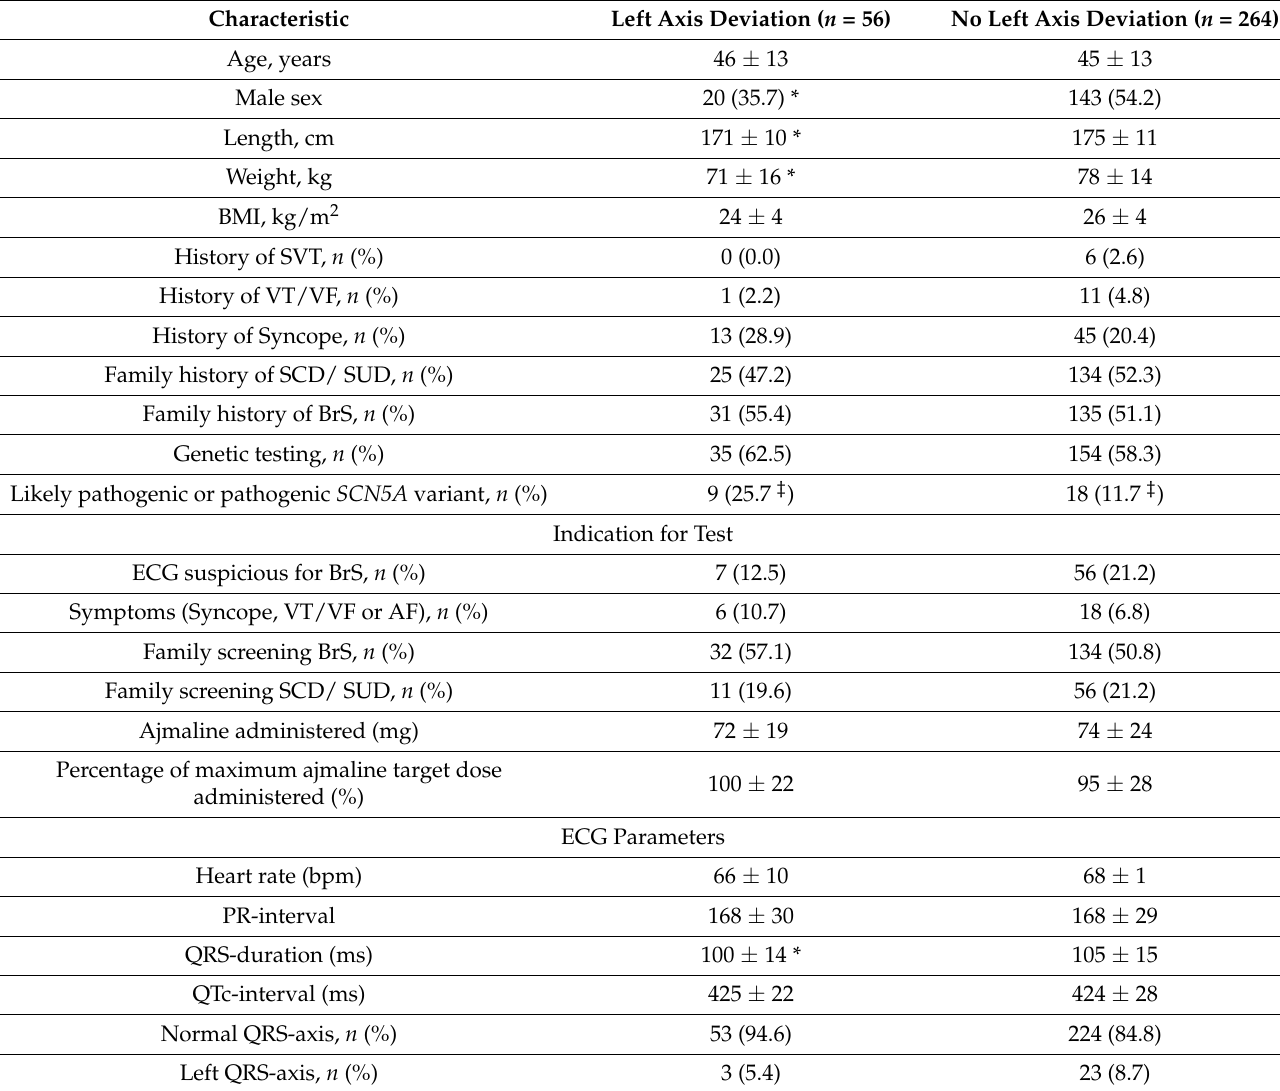
Table 1. Baseline